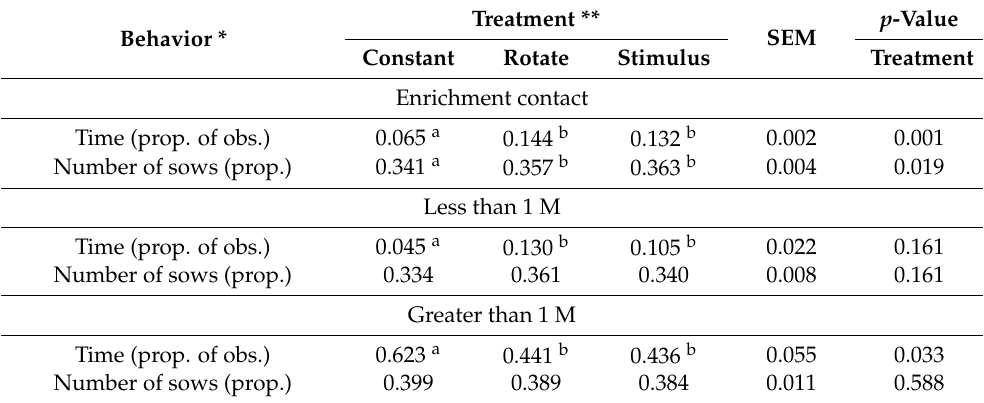
Table 5. Effects of enrichment treatment on time focal sows spent in contact with enrichment, less than 1 M or greater than 1 M from enrichment (% of observations) and number of focal sows near or in contact with enrichment (% of focal sows).